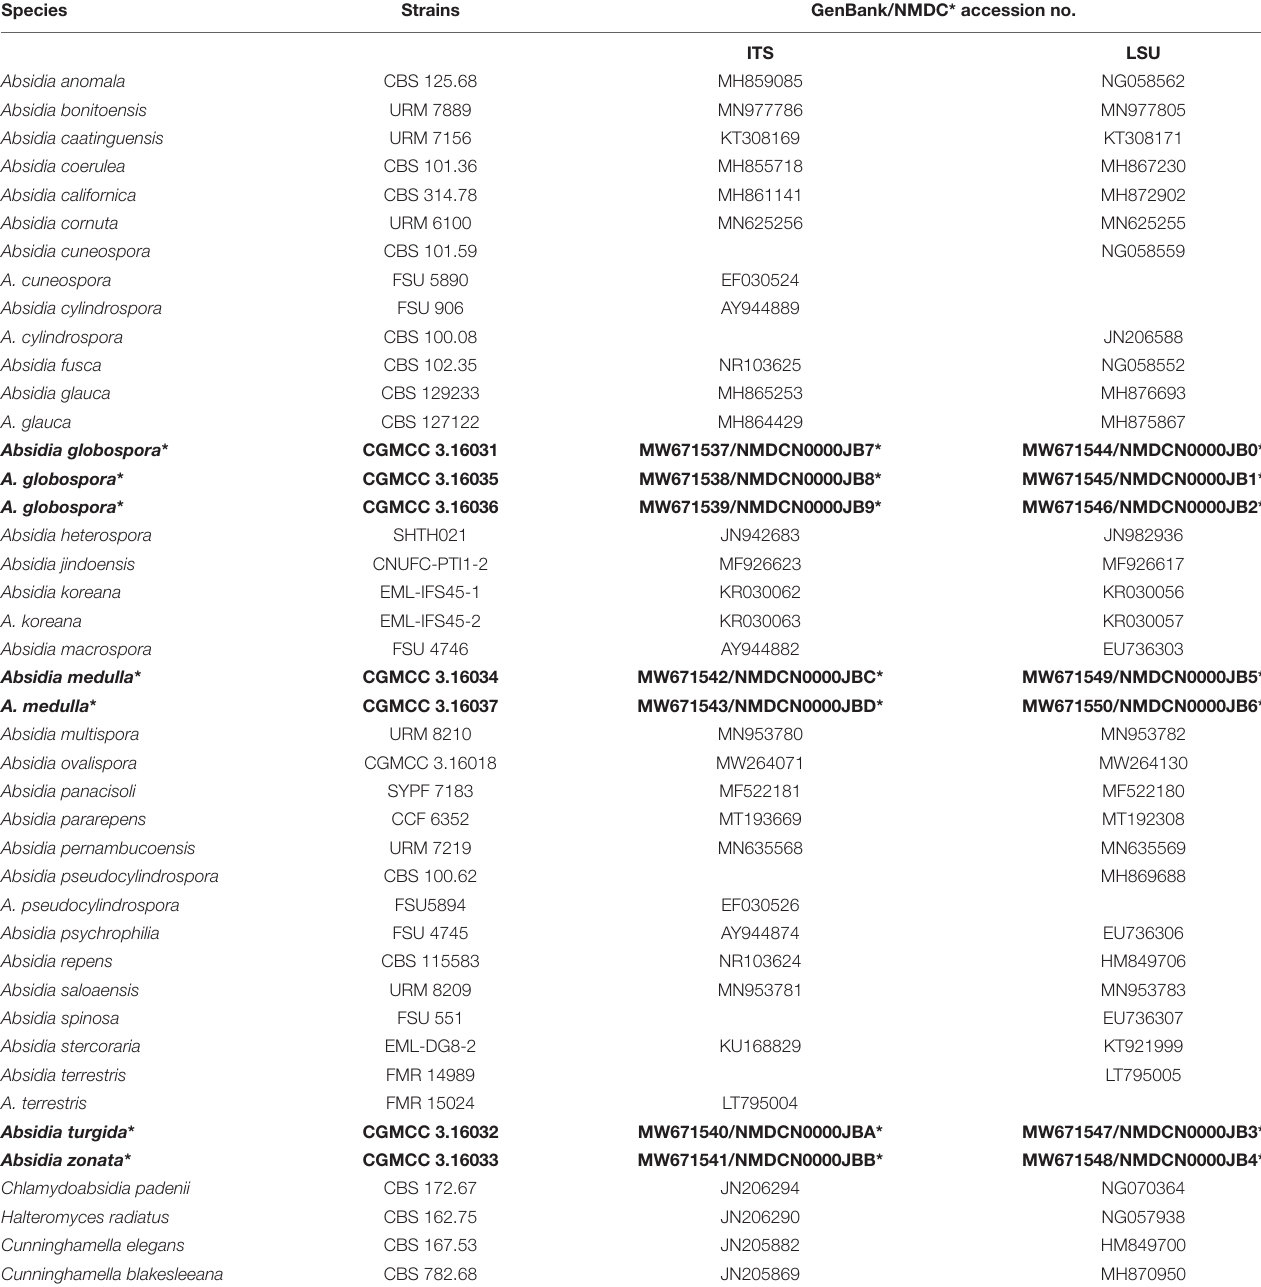
TABLE 1 | Species, strains, and GenBank/NMDC accession numbers used in this study. Species Strains GenBank/NMDC* accession no.